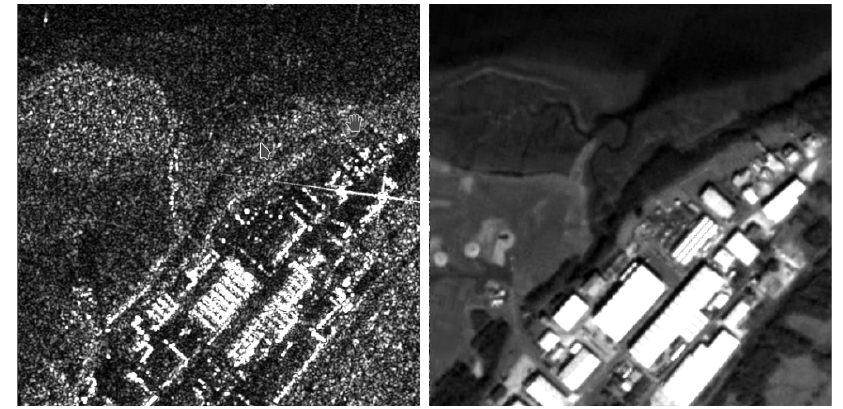
Figure 1. Comparison between acquired SAR ( left ) and optical ( right )